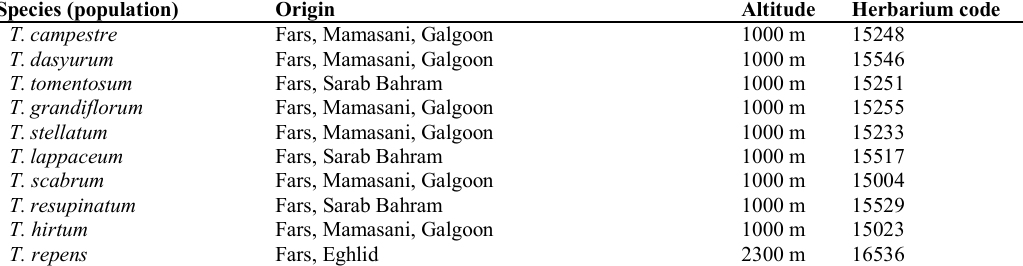
Table 1 . The origin of materials used in chromosome studies of Trifolium Species (population) Origin Altitude Herbarium code campestre